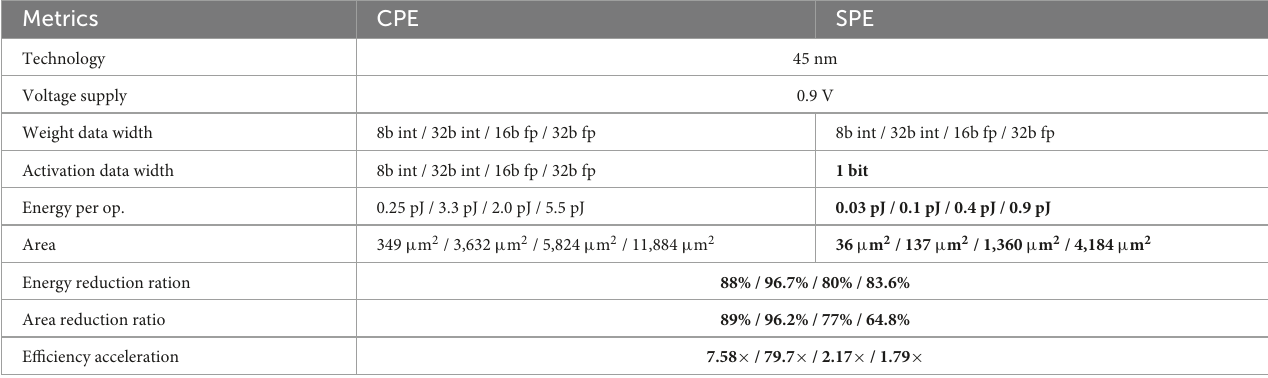
TABLE 2 Comparison of energy and area consumption between CNN-based PE (CPE) and spike-based PE (SPE). Metrics